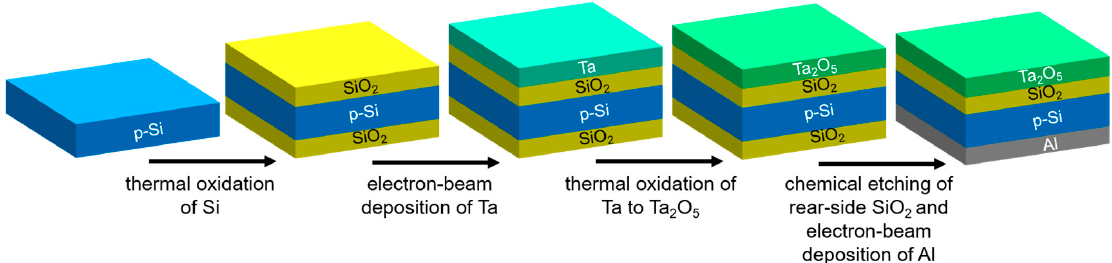
Figure 1. Fabrication process steps of the EIS chips (schematically).